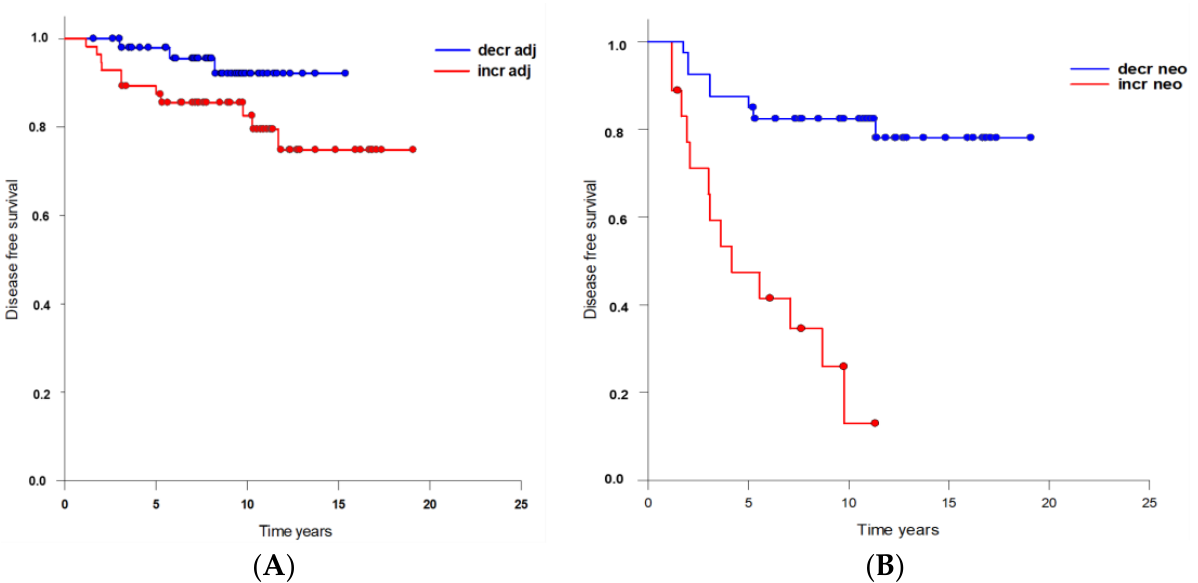
Figure 3. Association between ( A ) adjuvant chemotherapy ( p = 0.172) or ( B ) neoadjuvant chemo- therapy ( p < 0.001) and DFS depending on CETC/CTC behavior over the course of RT. In the neoadjuvant setting, there is no further therapeutic intervention between surgery and RT; therefore, the increase in cell numbers was correlated with time to relapse only in this group. The increase in cell numbers over the course of RT was inversely correlated to the time until metastases were detectable. Thus, in patients with a high increase (>10 times) of CETC/CTC numbers, metastases were detected earlier than in patients with a small increase (<10 times) (Figure 4).